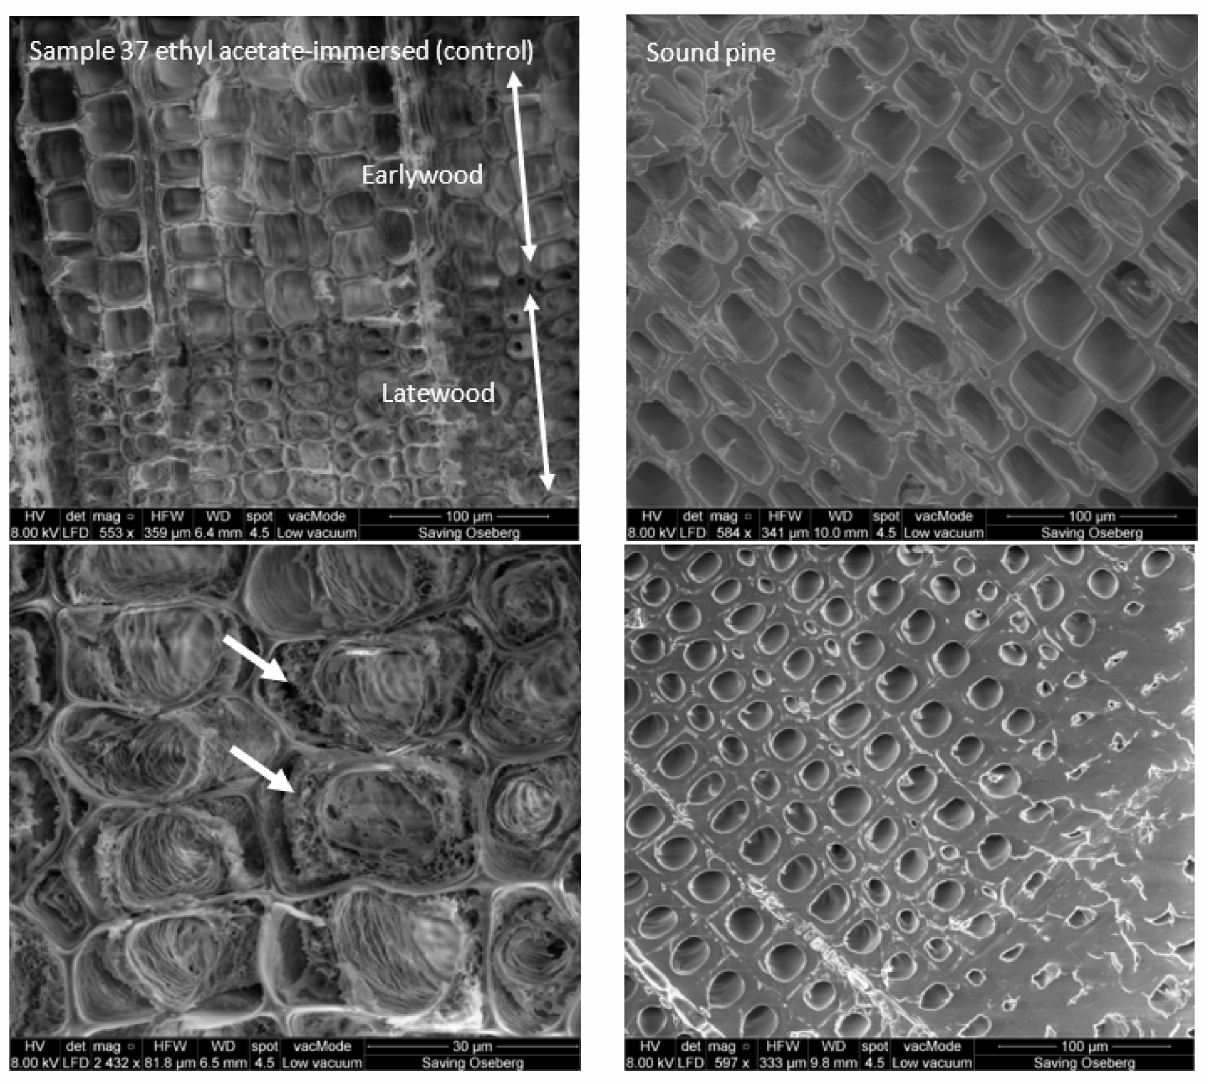
Figure 6. SEM images of the transverse faces of ethyl acetate-immersed sample 37 (control) on the left panel and of sound pine on the right panel. The upper right image shows the earlywood of sound pine, and the bottom right shows latewood cells of sound pine. The lower left image, which magnifies a region of latewood, shows the spongy nature of the secondary walls (arrows) in the archaeological